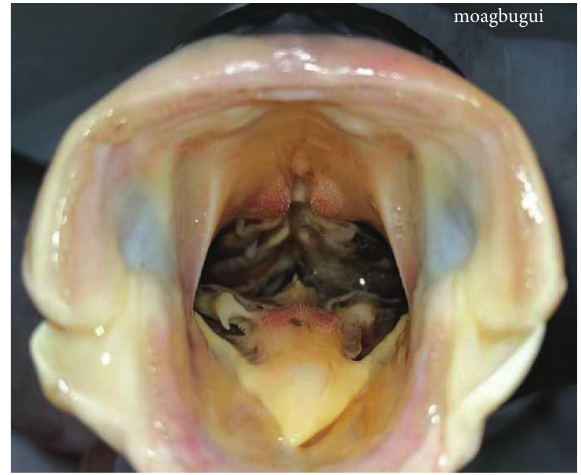
Figure 3: The gaping mouth of Heterotis niloticus , opening up to 12% of the total body